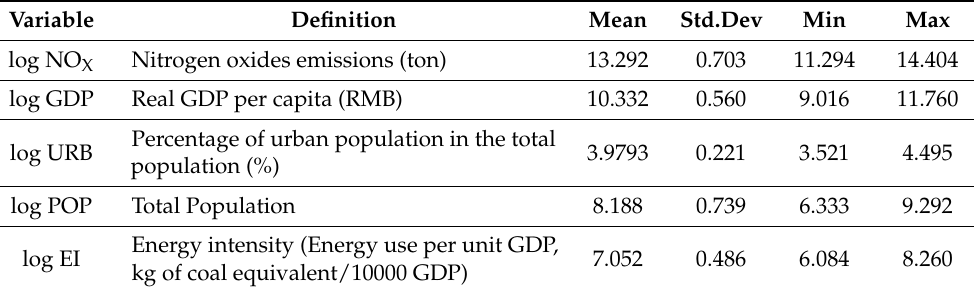
Table 1. Definitions and descriptive statistics of the